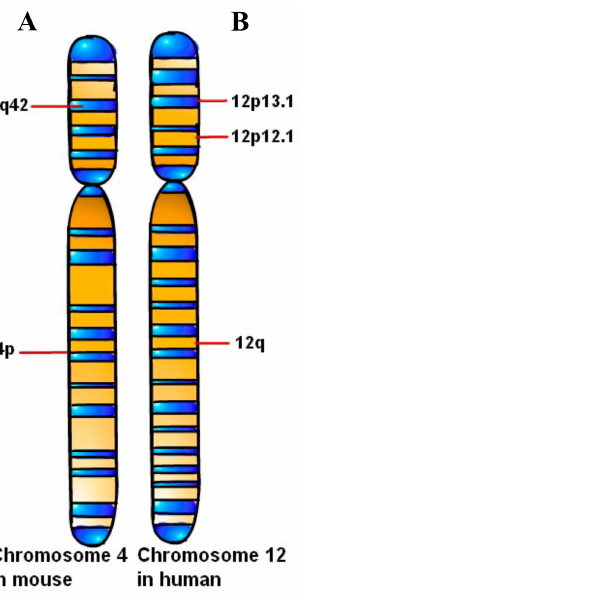
Figure 2. Chromosome localization of NKG2D. A: Mouse-derived NKG2D location on chromosome 4 and B: human-derived NKG2D location on chromosome